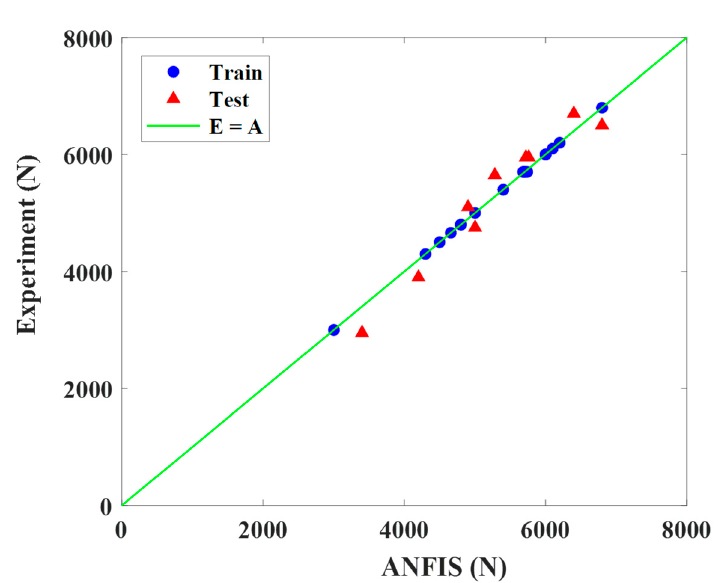
Figure 9. Comparison between experimental and predicted data.